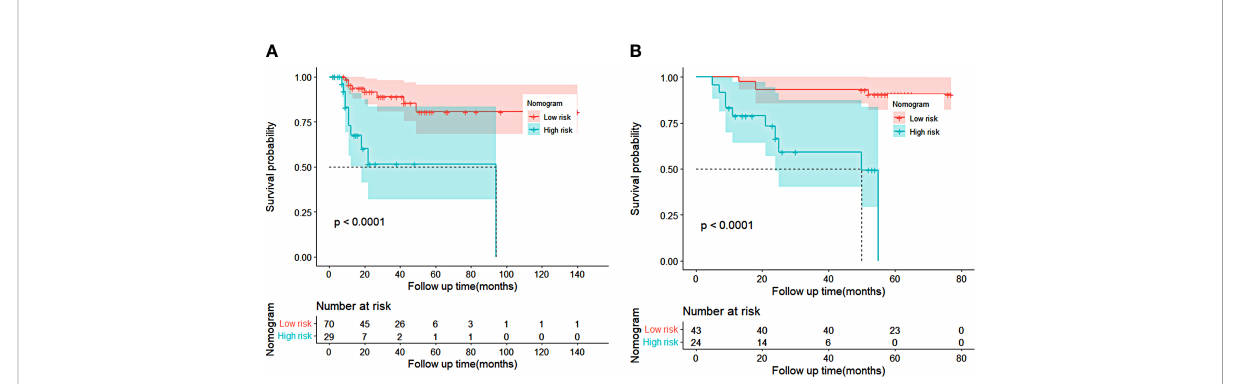
FIGURE 6 Kaplan – Meier curves of risk strati fi cation for overall survival (OS) based on the predictions of the nomogram in training cohort (A) and validation cohort (B) . Low risk: total points <100 for OS. High risk: total points ≥ 100 for